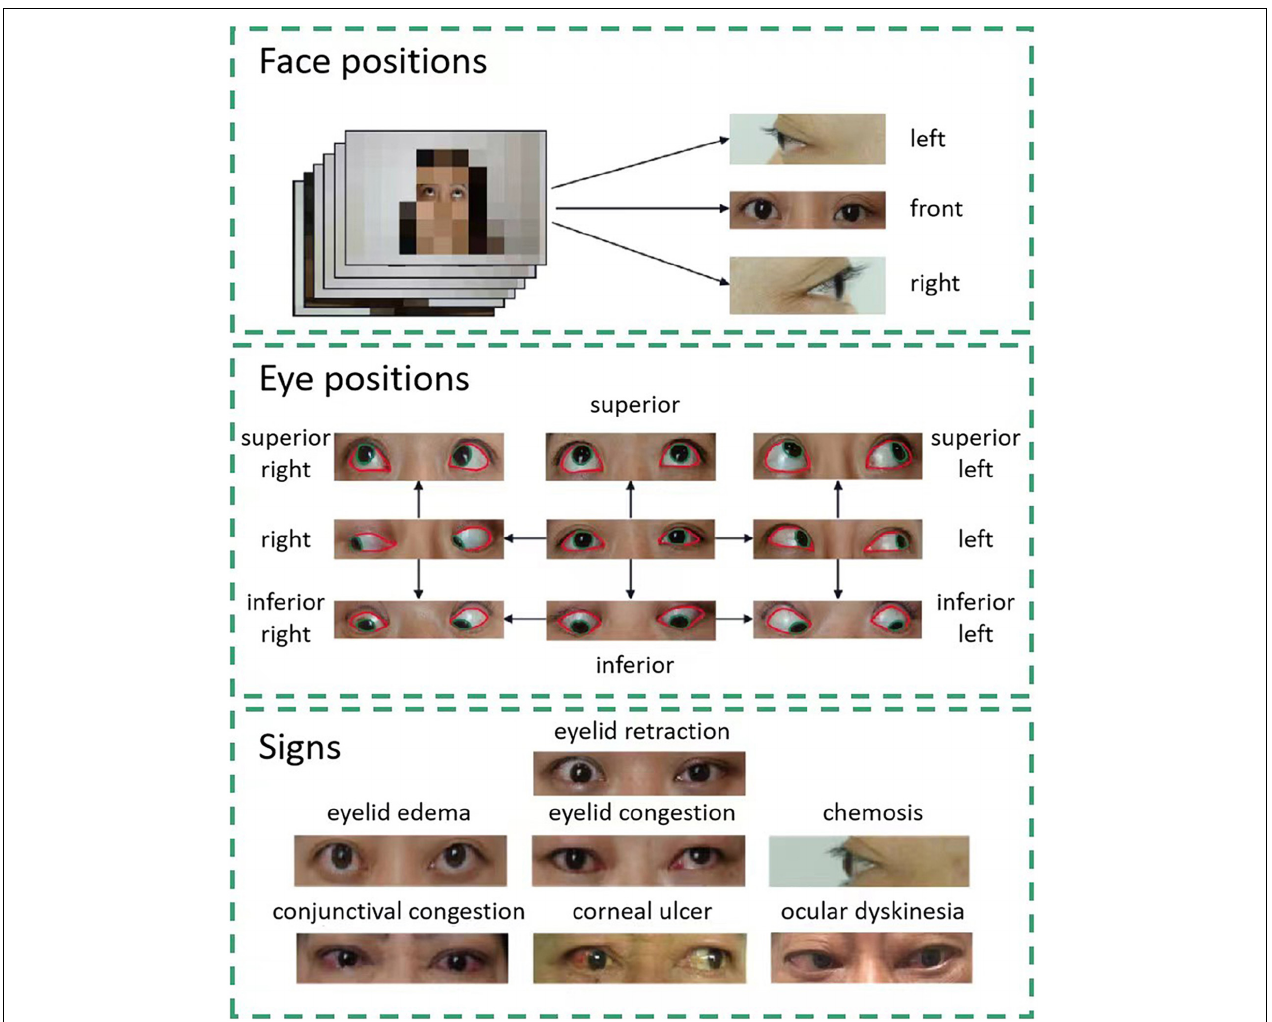
FIGURE 1 | Facial data collection and sign annotation. Images of three face positions and nine eye positions are included in the study. Each eye position image is labeled pixel-wise. The areas of the cornea and sclera are denoted by green and red lines, respectively. Using these images, the system can detect seven signs of thyroid-associated